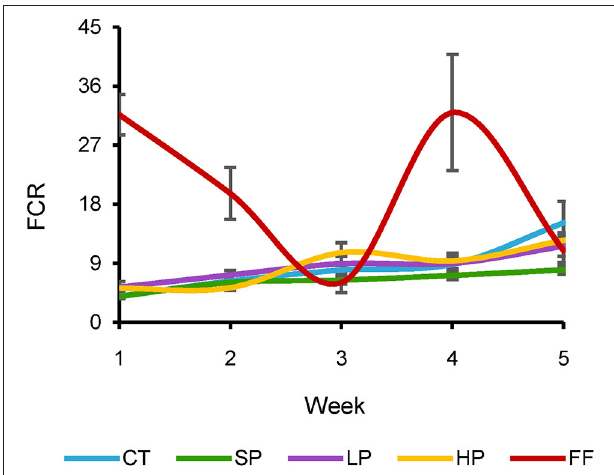
FIGURE 2 | Weekly estimates of Feed Conversion Ratio. Orthopteran-based diet, control diet, and Hypercaloric diet based on refined flours and sugary